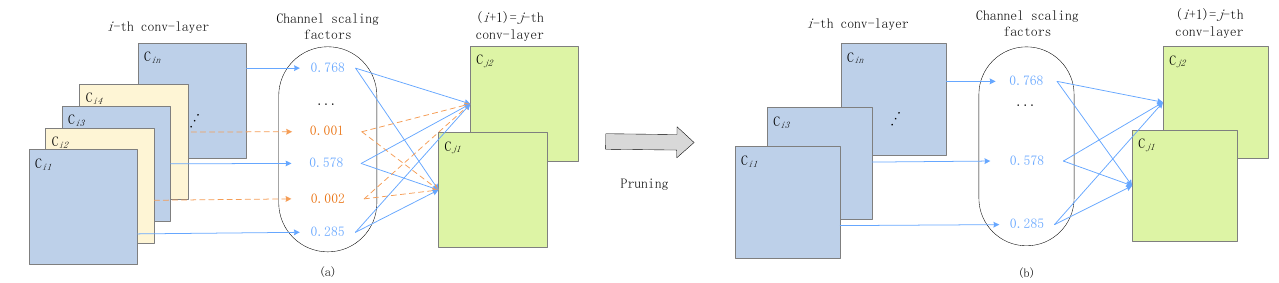
Figure 3. Strategies for sparse regularized channel pruning. ( a ) Structure before pruning. ( b ) Structure after